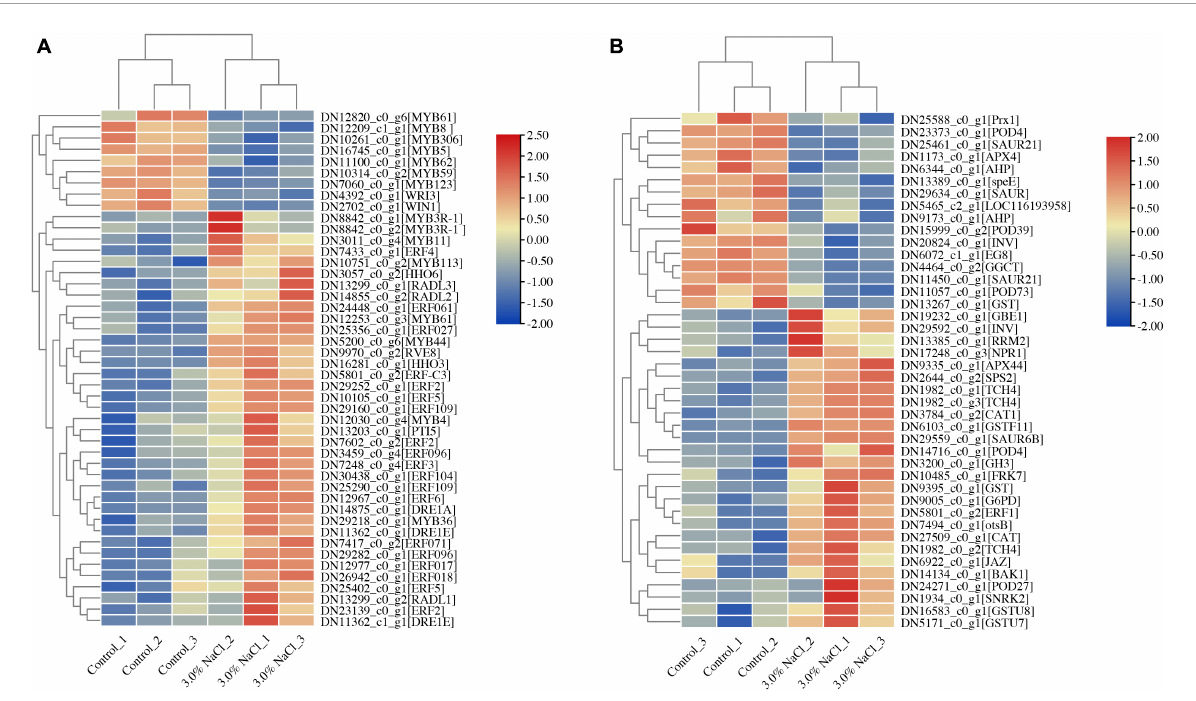
FIGURE7 Heatmaps of salt stress-responsive genes in S. caseolaris . (A) AP2/ERF and MYB Transcription factors, (B) plant phytohormones and antioxidant activity related